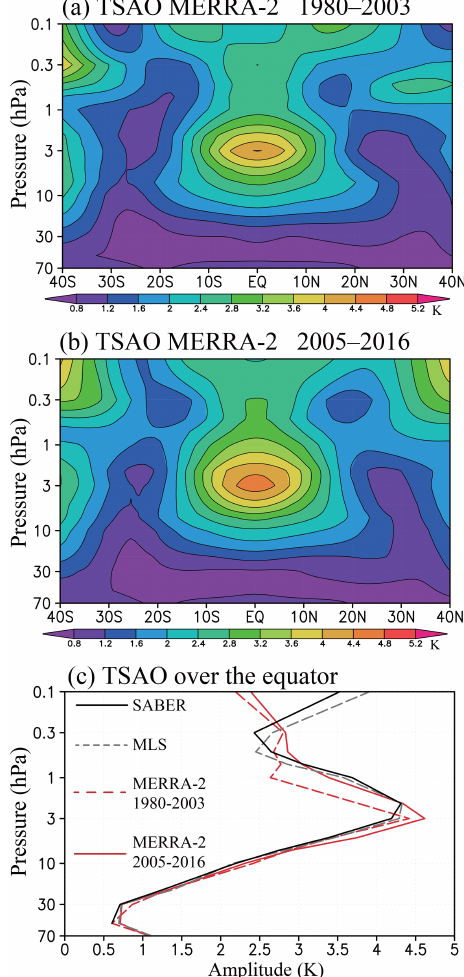
Figure 13. (a, b) Latitude–height cross section of SAO temperature amplitude for MERRA from (a) 1980 to 2003 and (b) 2005 to 2016. (c) Vertical profiles of SAO temperature amplitude over the Equa- tor for SABER (solid black), MLS (dashed black), MERRA-2 from 1980–2003 (dashed red), and MERRA-2 from 2005 to 2016 (solid